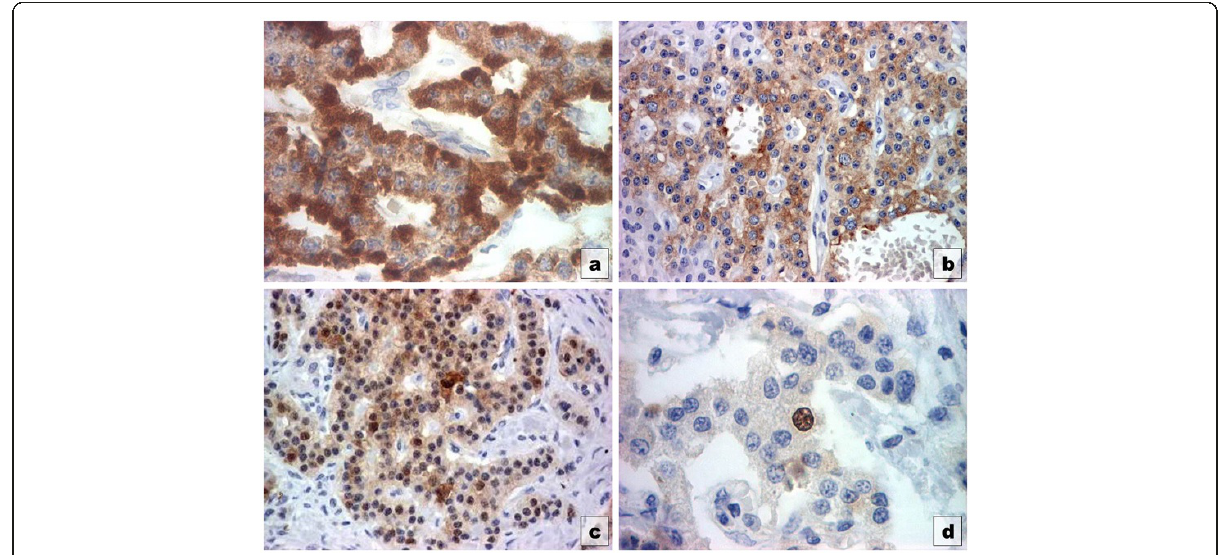
Figure 2 Immunohistochemical profile of the studied